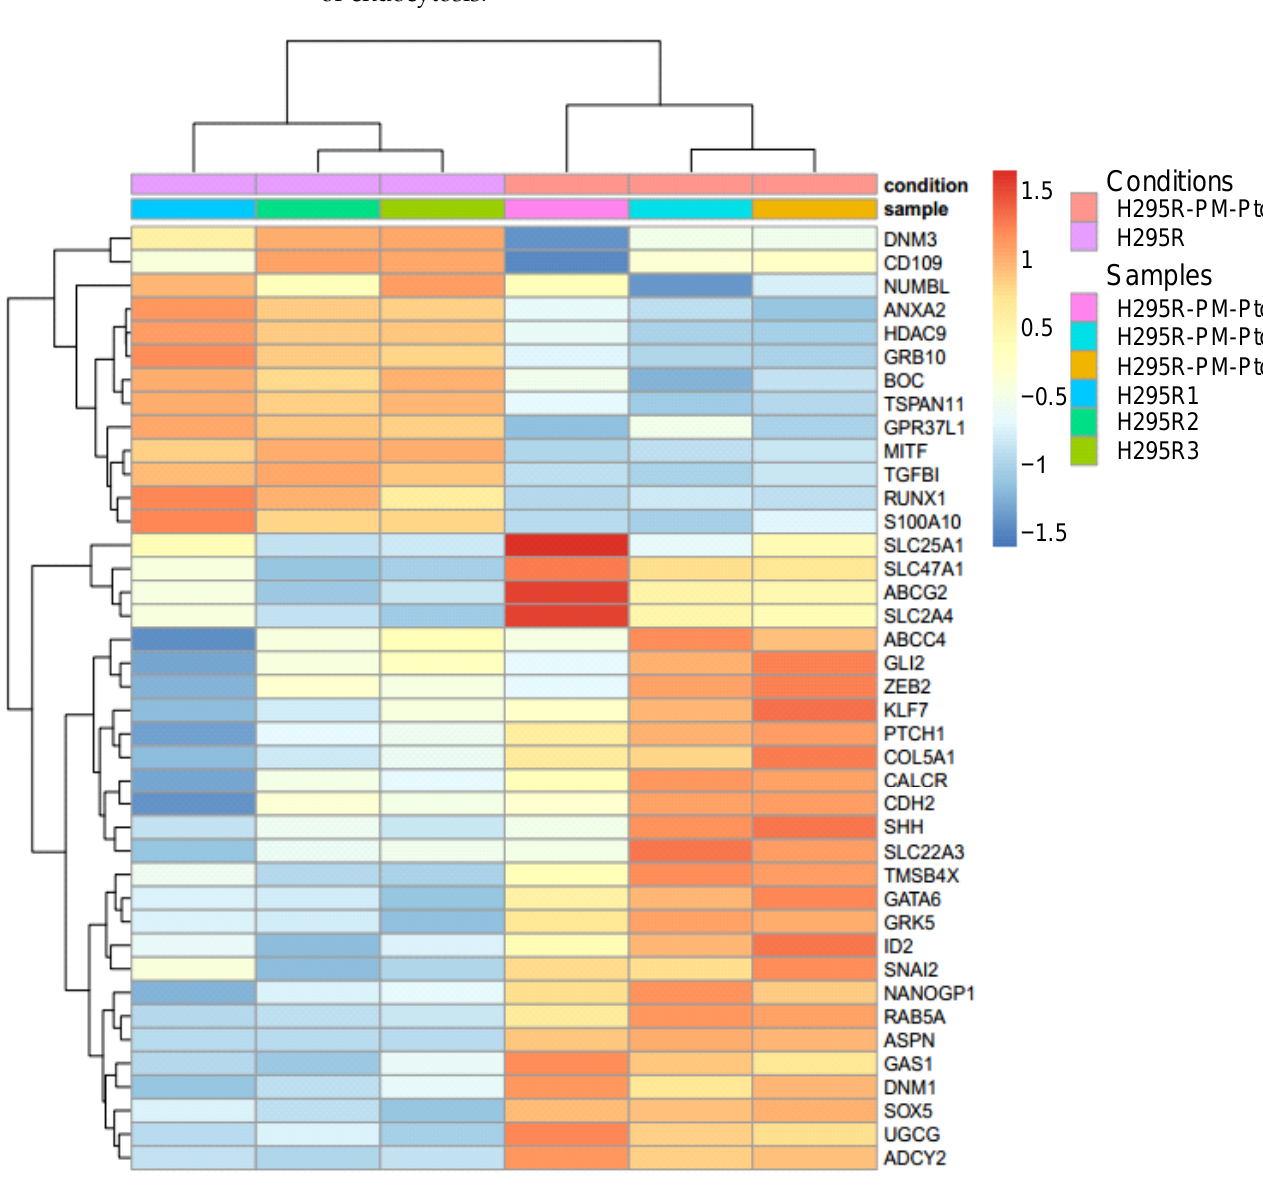
Figure 6. Heat map of differentially expressed genes (DEG) between H295R-PM-Ptc+ and parental H295R cells of interest for their role in cancer .